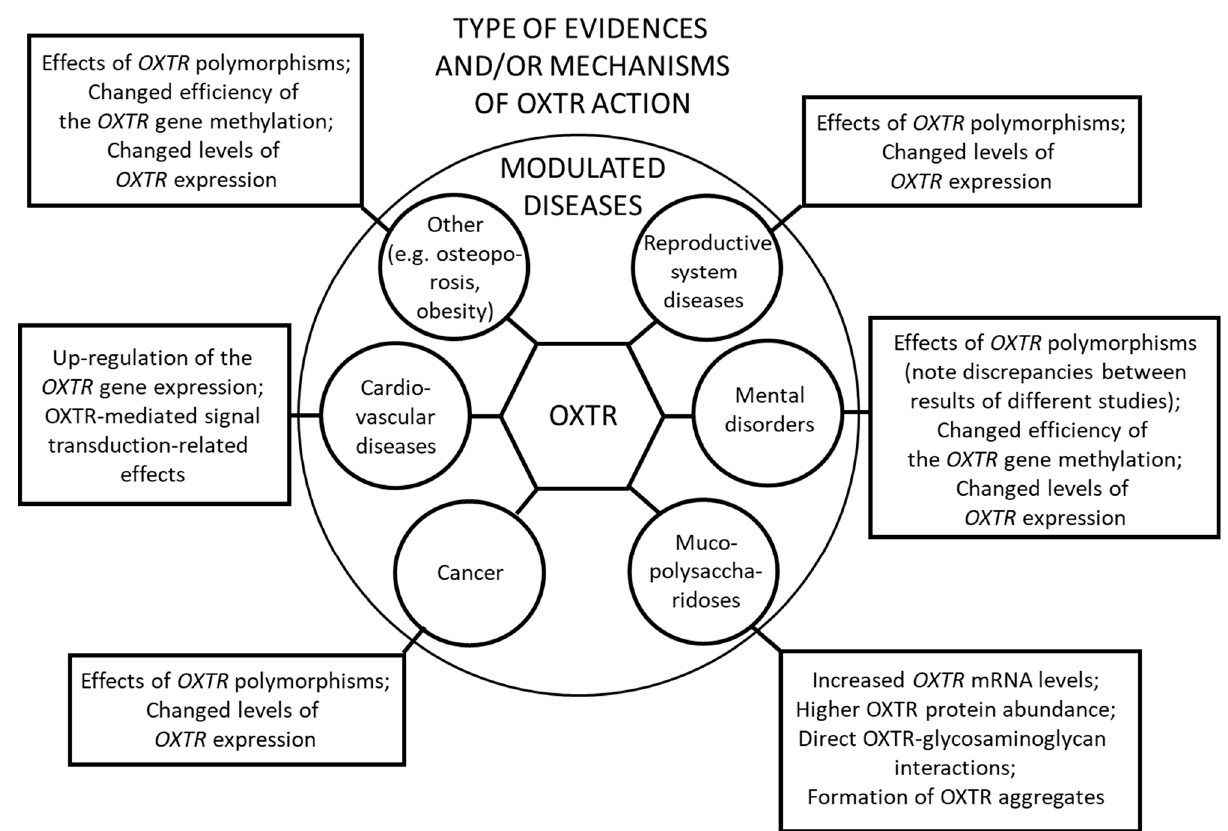
Figure 1. A simplified overview of the effects of OXTR on human diseases. Target (modulated) groups of diseases are indicated, together with major types of evidence of the influence of OXTR and/or mechanisms of actions of this receptor in specific diseases.